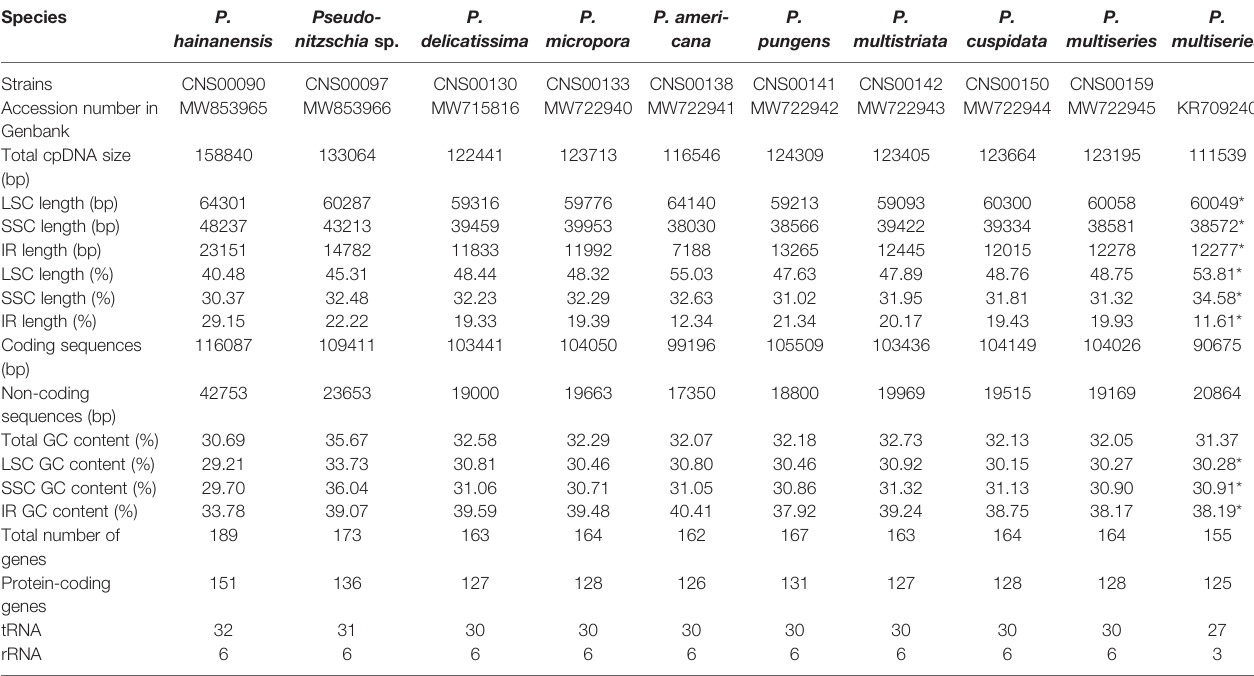
TABLE 3 | Molecular features of cpDNAs of nine Pseudo-nitzschia species.